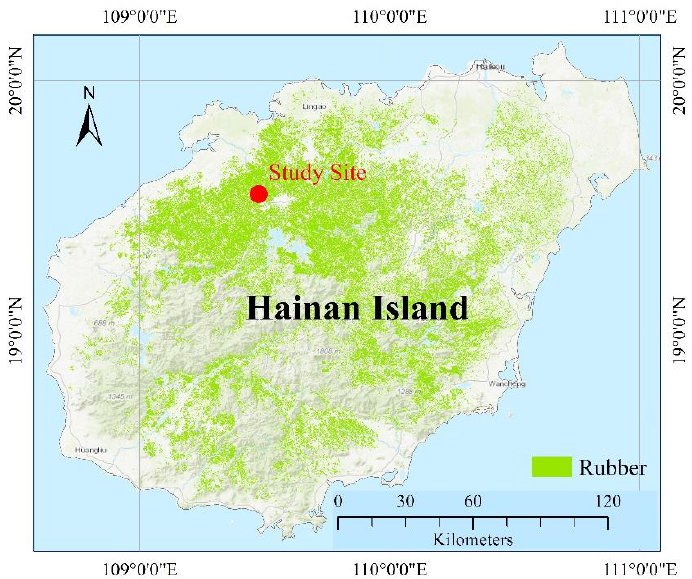
Figure 1. Study area (Study site: Danzhou Investigative and Experimental Station of Tropical Crops; The background topographic map sources: Esri, HERE, Garmin, Intermap, increment P Corp., GEBCO, USGS, FAO, NPS, NRCAN, GeoBase, IGN, Kadaster NL, Ordnance Survey, Esri Japan, METI, Esri China (Hong Kong), OpenStreetMap contributors, and the GIS User Community). The site, Danzhou Investigative and Experimental Station of Tropical Crops (19 ◦ 32 (cid:48) 47 (cid:48)(cid:48) N, 109 ◦ 28 (cid:48) 30 (cid:48)(cid:48) E), is in a rubber-dominated area and has an altitude of 114 m and flat